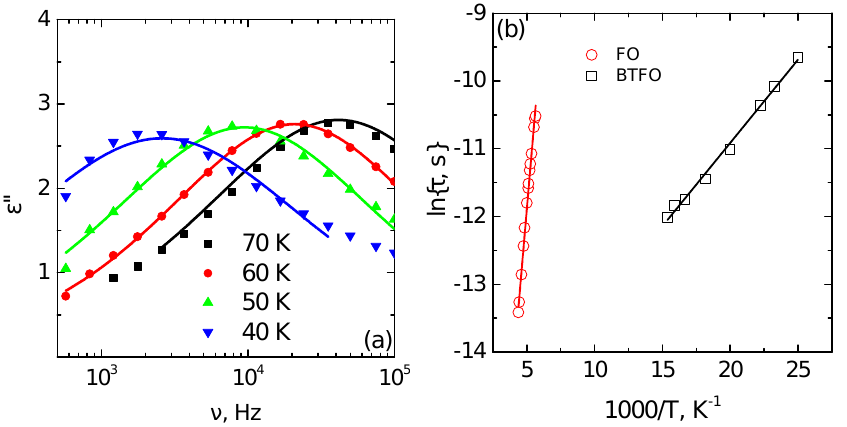
Figure 5. Frequency dependence of the dielectric losses of the BTFO sample: symbols—measured results, curves—Cole–Cole fit (2) ( a ). The temperature dependence of the relaxation time. Symbols— measured results; curves—Arrhenius fit ( b